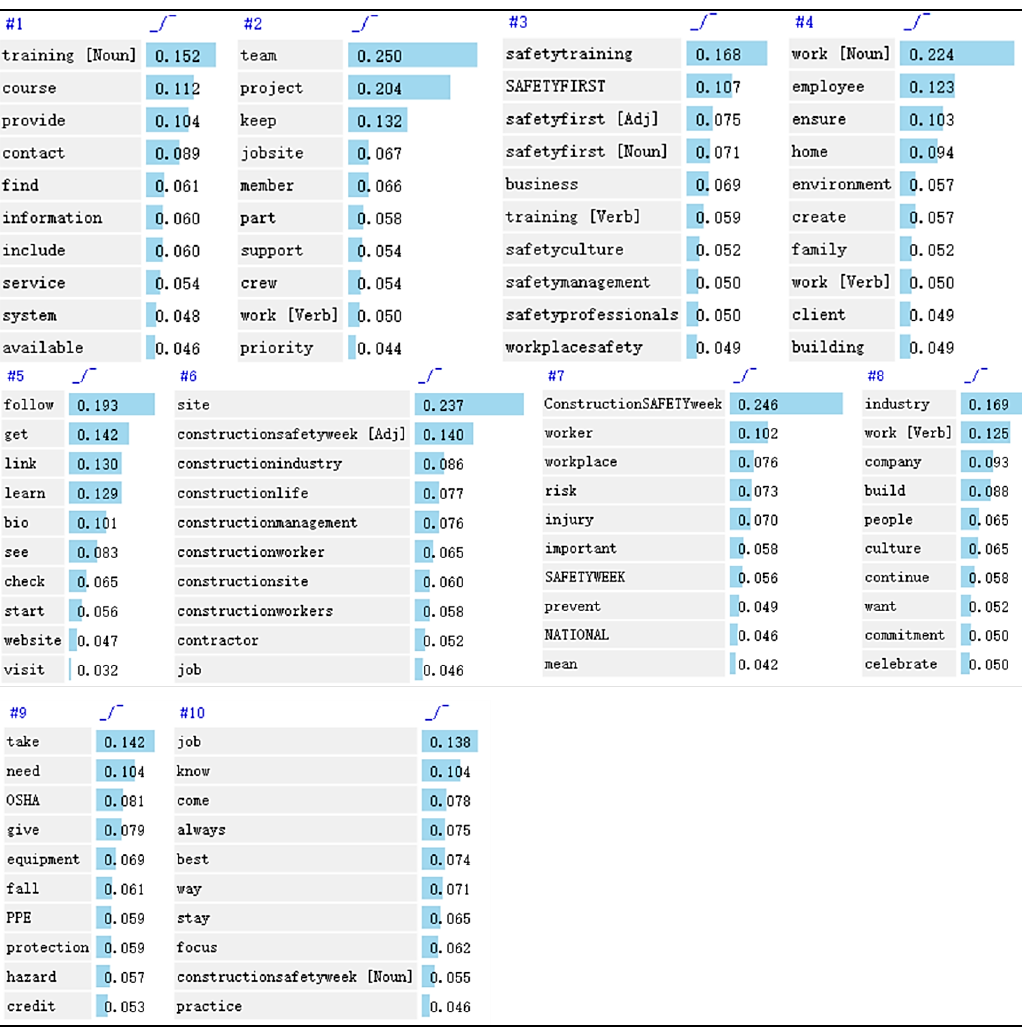
Figure 10. LDA topic model about construction health and safety on Instagram.